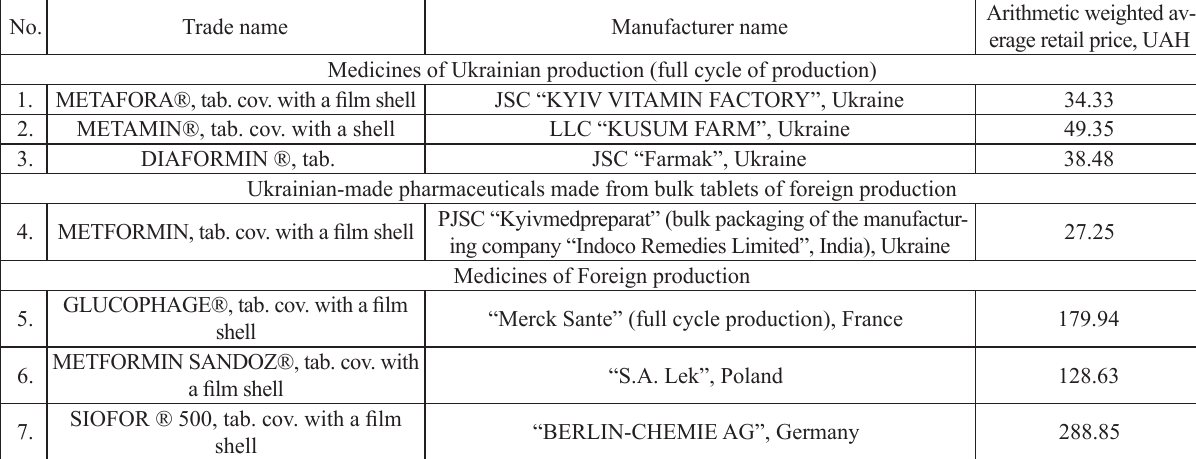
Arithmetic weighted average retail price of medicines metformin HCL in tablets (UAH per package)